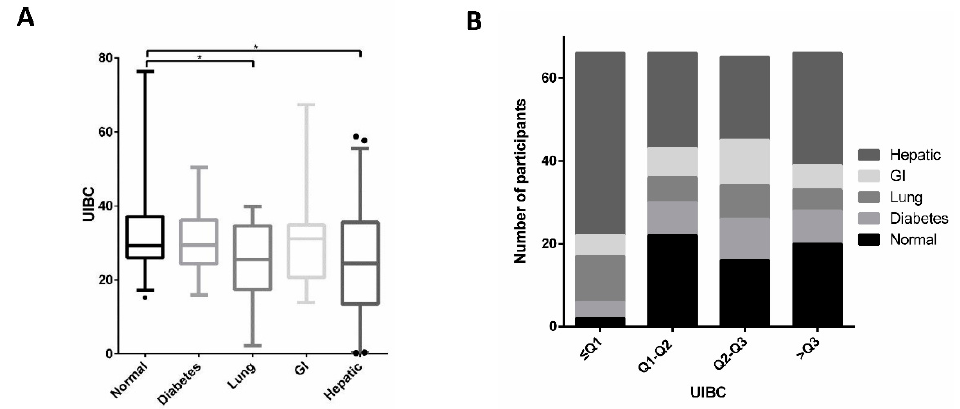
(51.783) of MTC, respectively. ( D ) Colorimetric feature of MTC assay. Samples from normal group (abbreviated as N and highlighted by black square) shows purple color due to the lower A660 read- ing. In contrast, samples from patients with hepatic cancer (abbreviated as H) have higher A660 reading which resulted in more green colors. Lung cancer and diabetic samples are labelled as L and D, respectively.